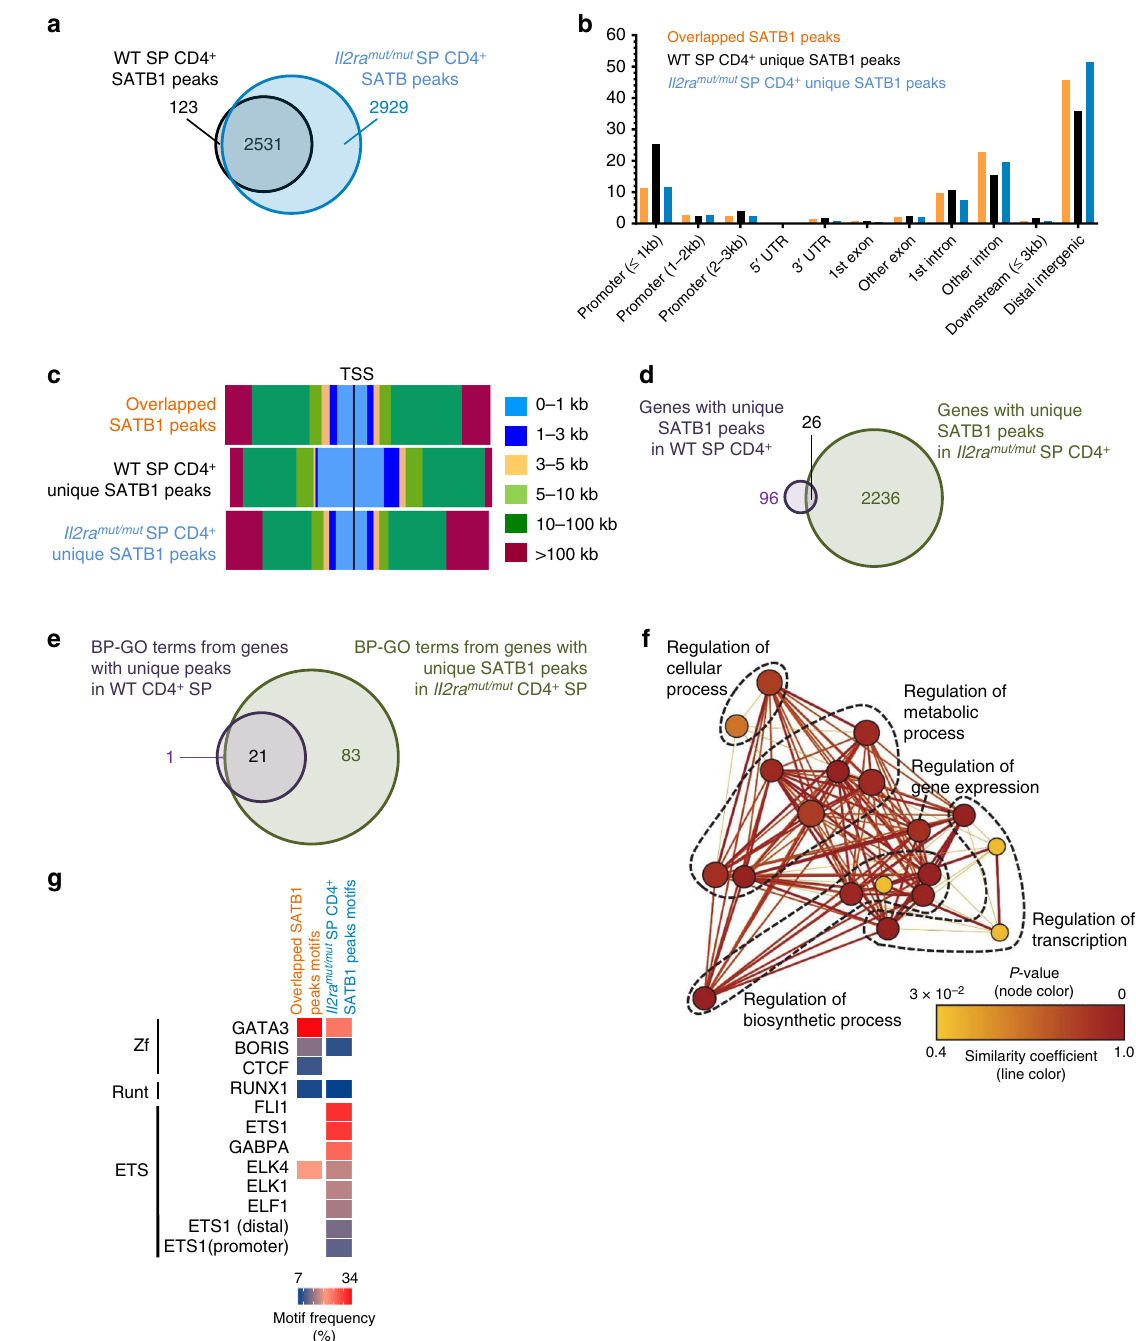
Fig. 5 Ectopic DNA binding of SATB1 in SP CD4 + thymocytes receiving low IL-2 signals: 2 × 10 6 SP CD4 + thymocytes were sorted in 2 independent duplicate experiments by fl ow cytometry from the thymus of Il2ra mut/mut and WT mice, PFA fi xed, lysed, and cross-linked DNA was used for chromatin immunoprecipitation sequencing (ChIP-seq) of the pioneer factor SATB1. a Venn diagram of the number of common and unique SATB1 DNA binding peaks in Il2ra mut/mut vs WT SP CD4 + thymocytes. b , c Distribution of common and unique SATB1 DNA binding peaks across gene organization ( b ) and distance to the transcription start site (TSS, c ) in the whole genome. d Venn diagram of the number of genes exhibiting unique SATB1 DNA binding peaks in Il2ra mut/mut vs WT SP CD4 + thymocytes. e Venn diagram of biological-process gene-ontology (BP-GO) from genes with unique SATB1 DNA binding peaks in WT vs Il2ra mut/mut SP CD4 + thymocytes. f Network analysis of BP-GO term enrichment among genes with unique SATB1 DNA binding peaks in WT SP CD4 + thymocytes. Genes with unique SATB1-binding peaks were analyzed for over-represented GO terms using BiNGO in Cytoskape, and the resulting network was calculated and visualized using EnrichmentMap in Cytoscape. Groups of similar GO terms were manually circled. Line thickness and color are proportional to the similarity coef fi cient between connected nodes. Node color is proportional to the FDR-adjusted p -value of the enrichment. Node size is proportional to gene set size. g Frequency of known TF binding site motifs enriched in common and unique SATB1 DNA binding peaks in WT and Il2ra mut/mut SP CD4 + thymocytes. Motif frequency (%) is shown in heat